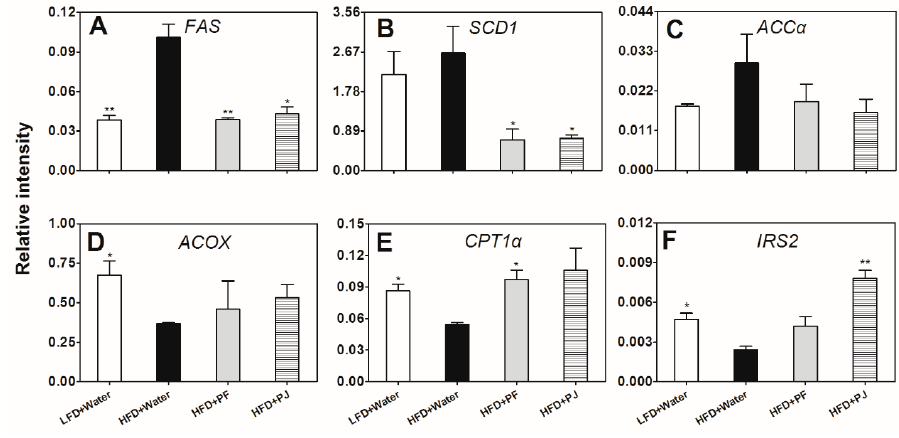
Figure 6. Effect of PF and PJ extracts on relative gene expression of FAS ( A ); SCD1 ( B ); ACC α ( C ); ACOX ( D ); CPT1 α ( E ); and IRS2 ( F ) in livers of HFD C57BL/6 mice. Data are presented as mean ± SEM ( n = 4). * p < 0.05, ** p < 0.01, compared to the HFD group treated with water.